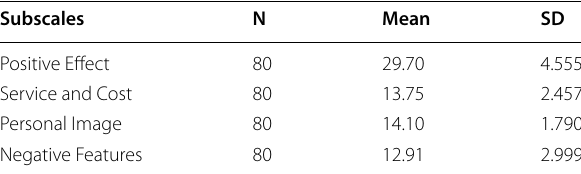
Table 2 Mean satisfaction score obtained by the participants